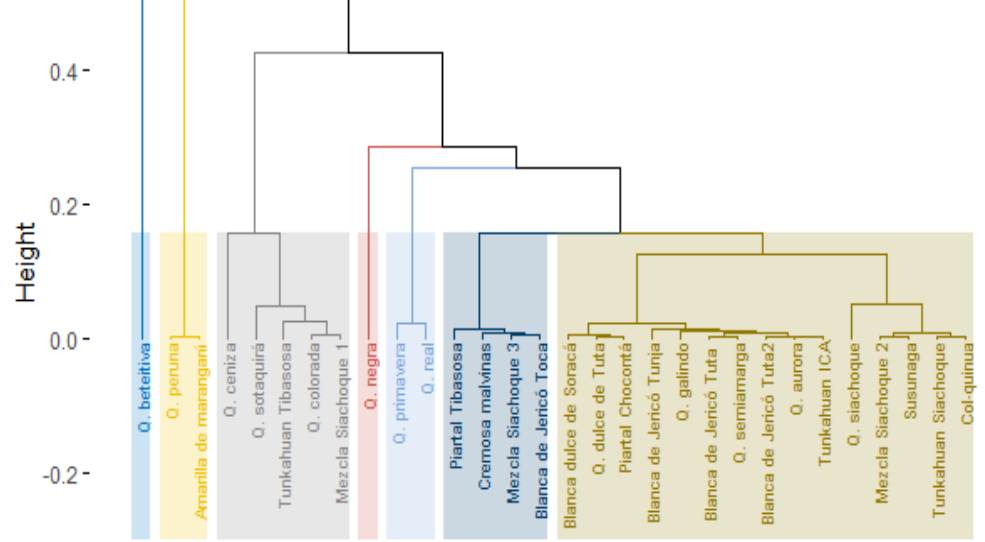
Figure 6. Cluster analysis showing seven groups of quinoa accessions formed according to the qualitative variables.